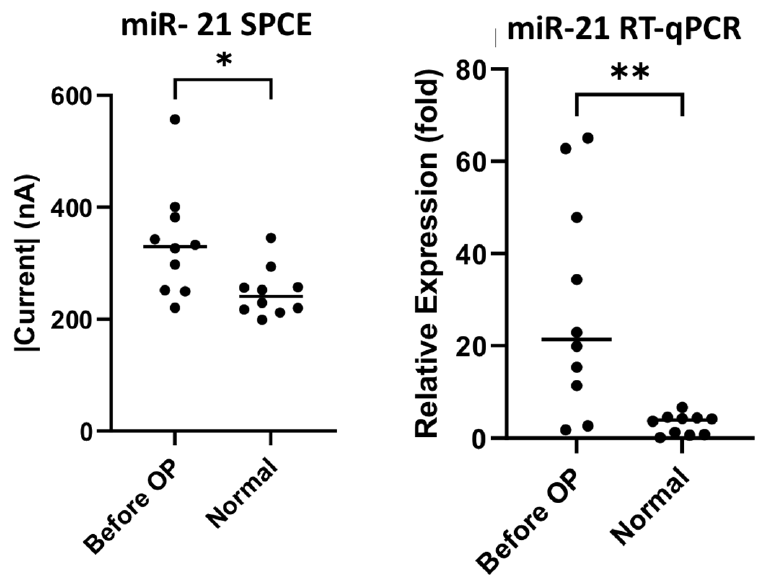
Figure 5. miR-21 sensor detection and RT-qPCR analysis of urine samples of colorectal cancer patients and healthy subjects. * p -value < 0.05, ** p -value < 0.005.